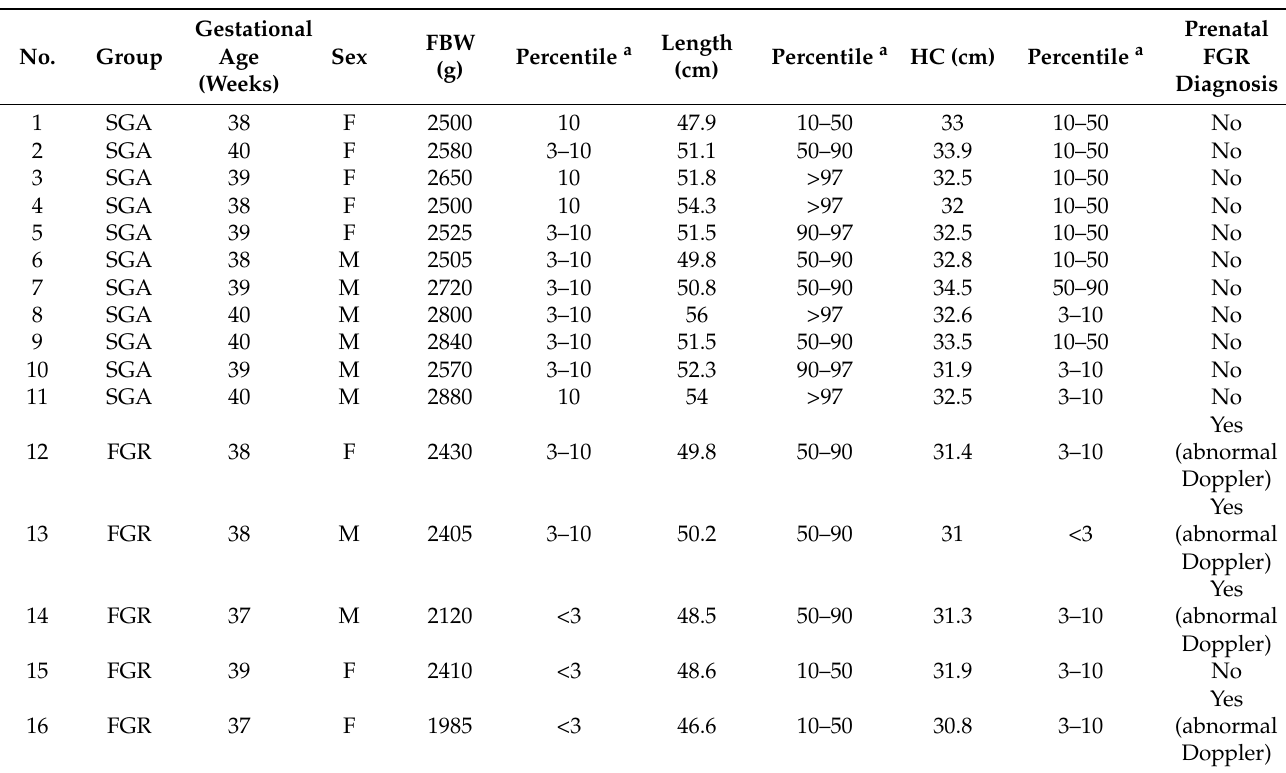
Table 1. Clinical characteristics of SGA and FGR